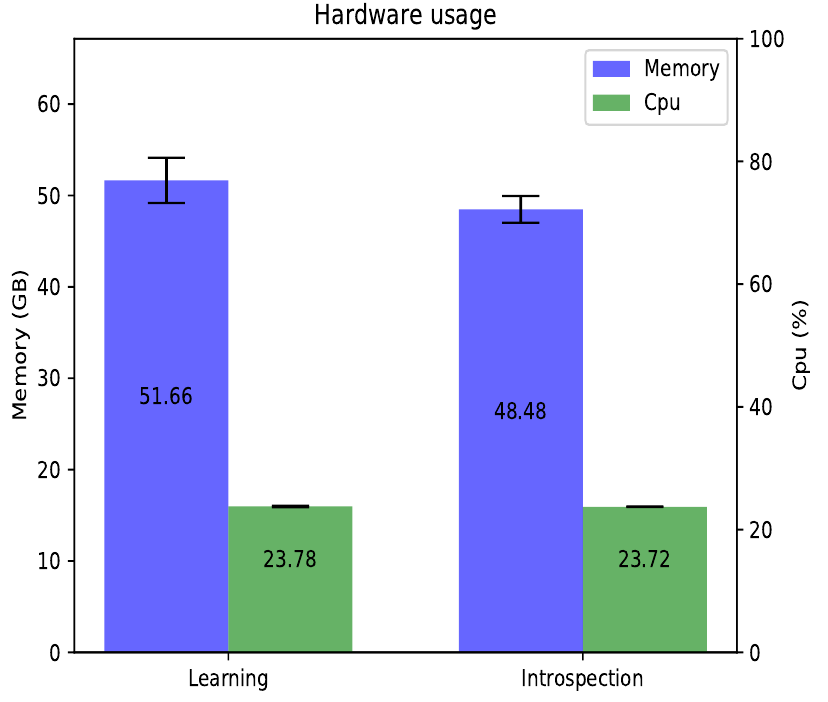
Figure 8. Values for use of resources considering RAM memory and percentage of processor use (CPU). Average value and standard deviation are computed for three training processes during 200 episodes for each method. The y axis on the left relates to the gigabyte scale, and the percentage is on the right. A lower standard deviation is shown for the introspection method for memory use. This indicates greater stability using this resource. For the case of the CPU, both methods maintained a not null standard deviation close to